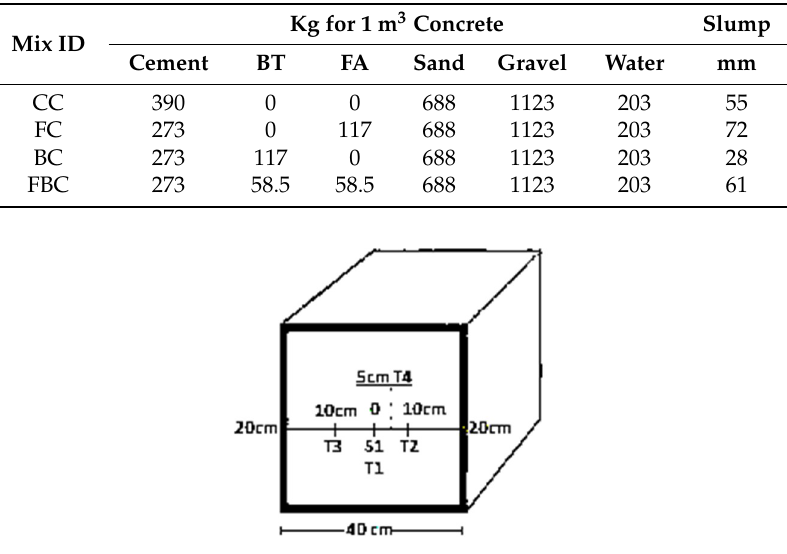
Figure 1. Location of thermocouples in a mass concrete specimen.